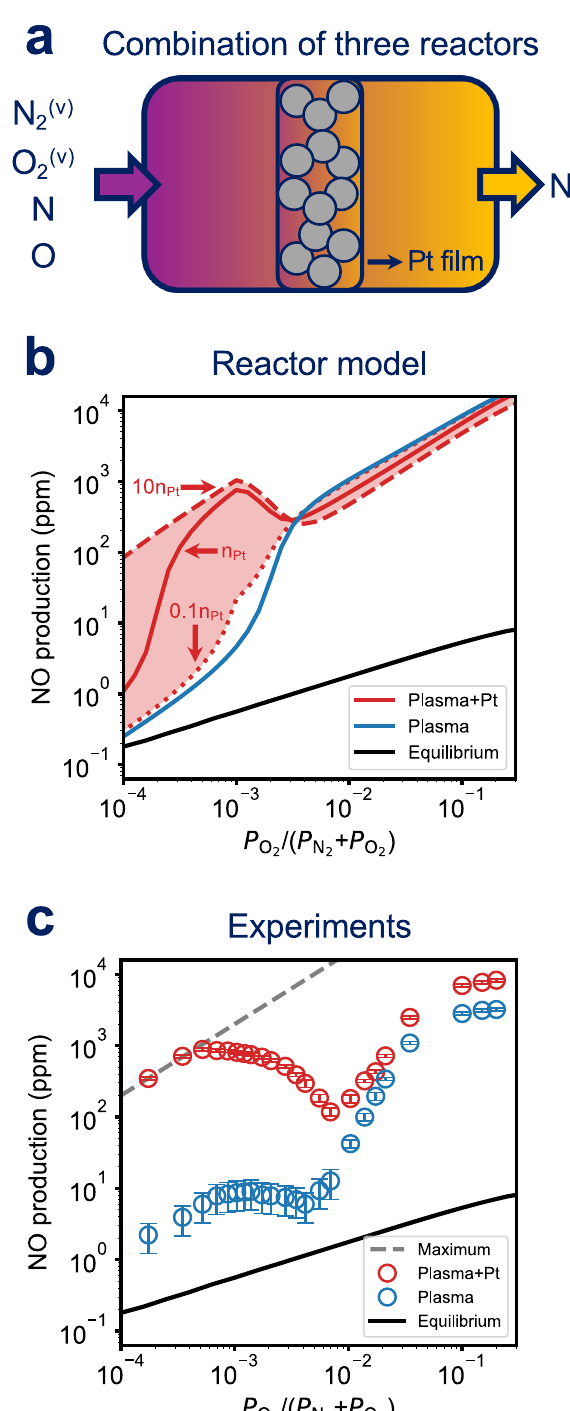
Fig. 6 Composition sensitivity. a Series of three integral reactors to describe the reactor of Fig. 1. b NO production as a function of O 2 pressure in plasma-only and plasma-catalytic reactor series at P N ¼ 2 ´ 10 (cid:3) 3 P N = 6000 K, and bulk temperature 873K. Red solid line represents a Pt T vib active site number of 230nmol and dashed and dotted line represent order- of-magnitude variations in that number. c Observed NO production vs O 2 pressure ratio. Maximum represents all O 2 coverts to NO. Total reactor pressure is 5mbar. The error bars represent the standard deviation of at least three